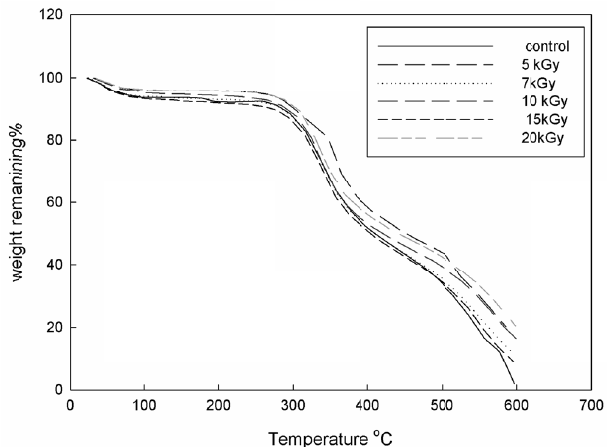
Fig. 6. TGA curves of untreated and AgNPs-treated silk fabric with different gamma irradiation